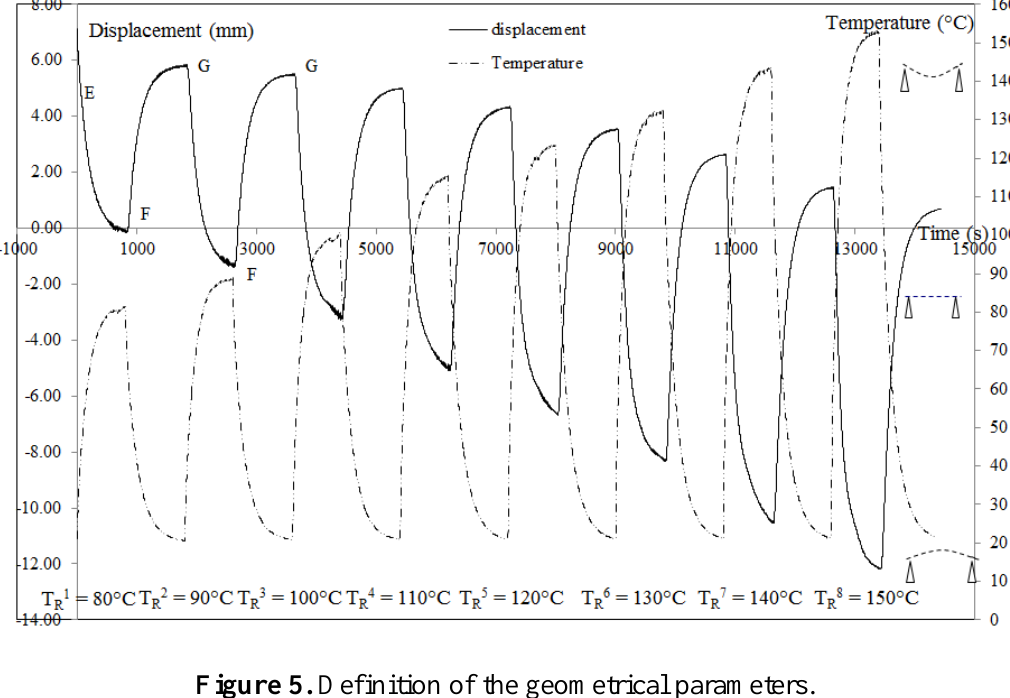
Figure 4. Recovery displacements for an unconstrained multi-step recovery cycle, d I = 7.28 ± 0.89 mm, ( ε I F T . Loading equal to the preload of 0.3 N. a